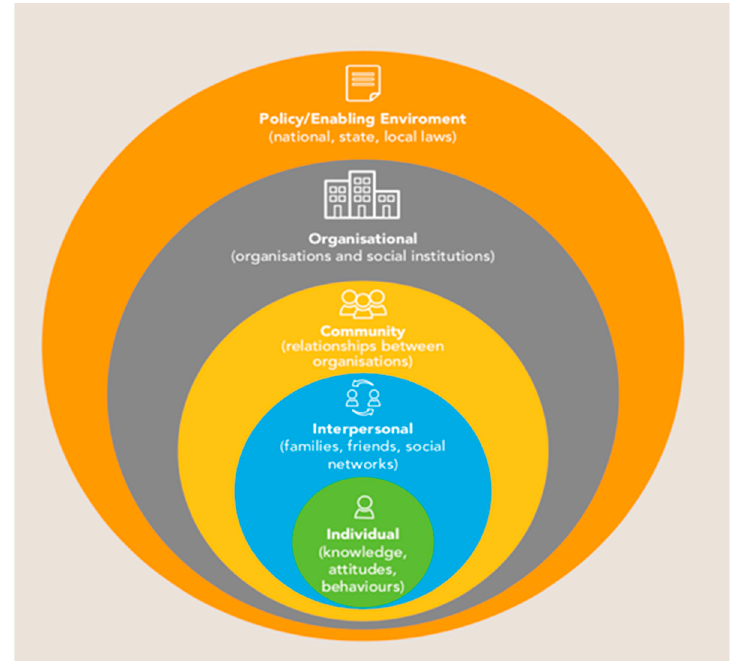
Figure 1. Socio-ecological model [57].